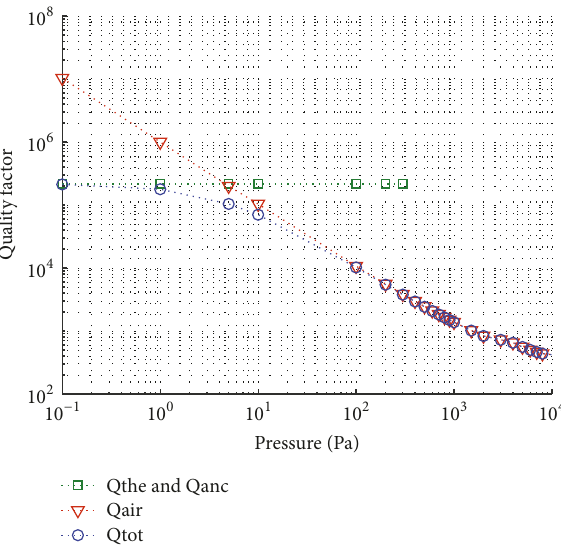
Figure 10: Total quality factor Q temperature of 20 ∘